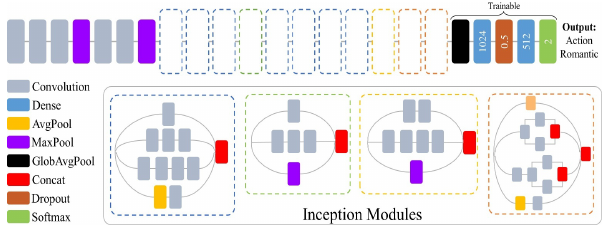
Figure 5. Structure of the proposed InceptionV3 neural network.